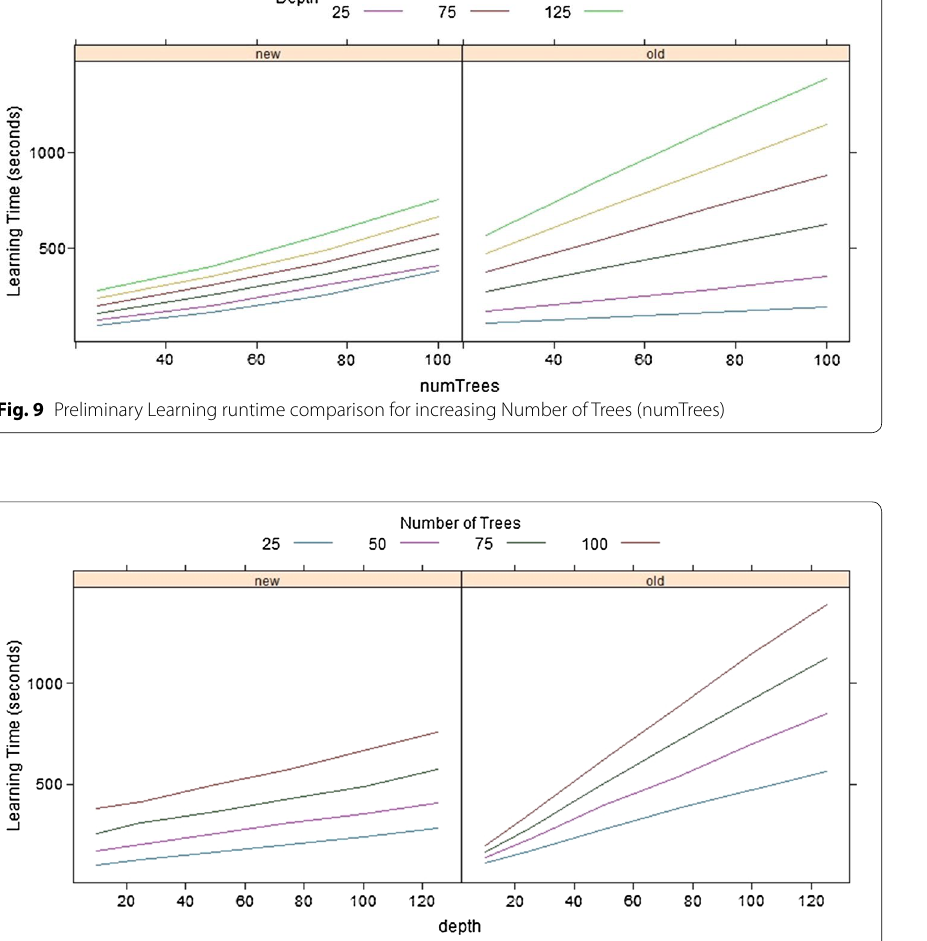
Fig. 10 Preliminary Learning runtime comparison for increasing maximum level of trees